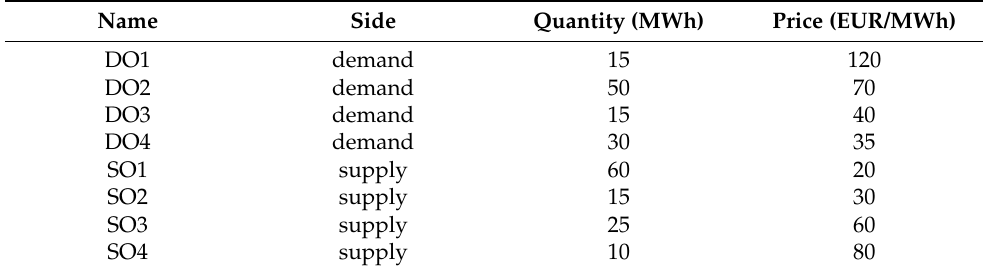
Table 2. Parameters of submitted orders in the clearing example.